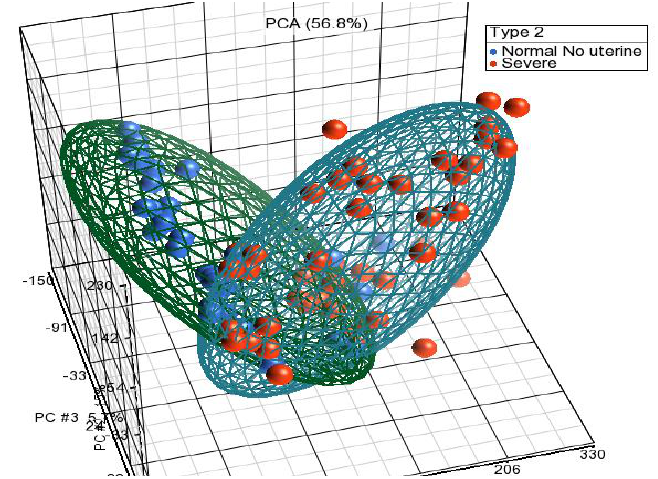
Figure 6. The network indicated a strong interplay of various proteins and their specific involvement